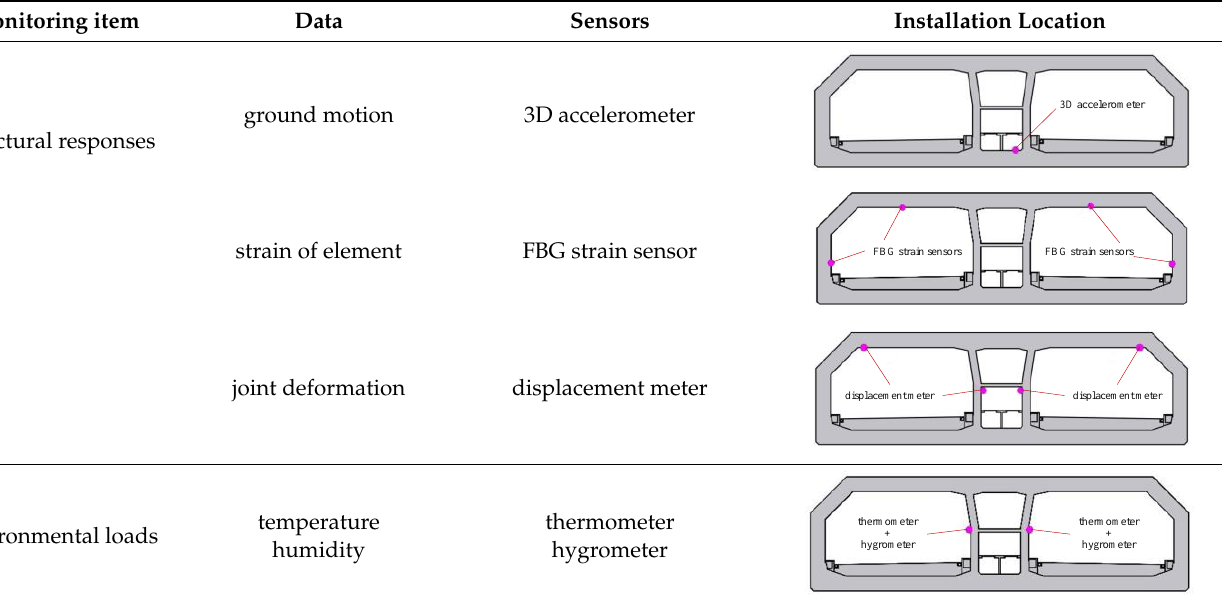
Table 2. Health monitoring contents and corresponding sensors.